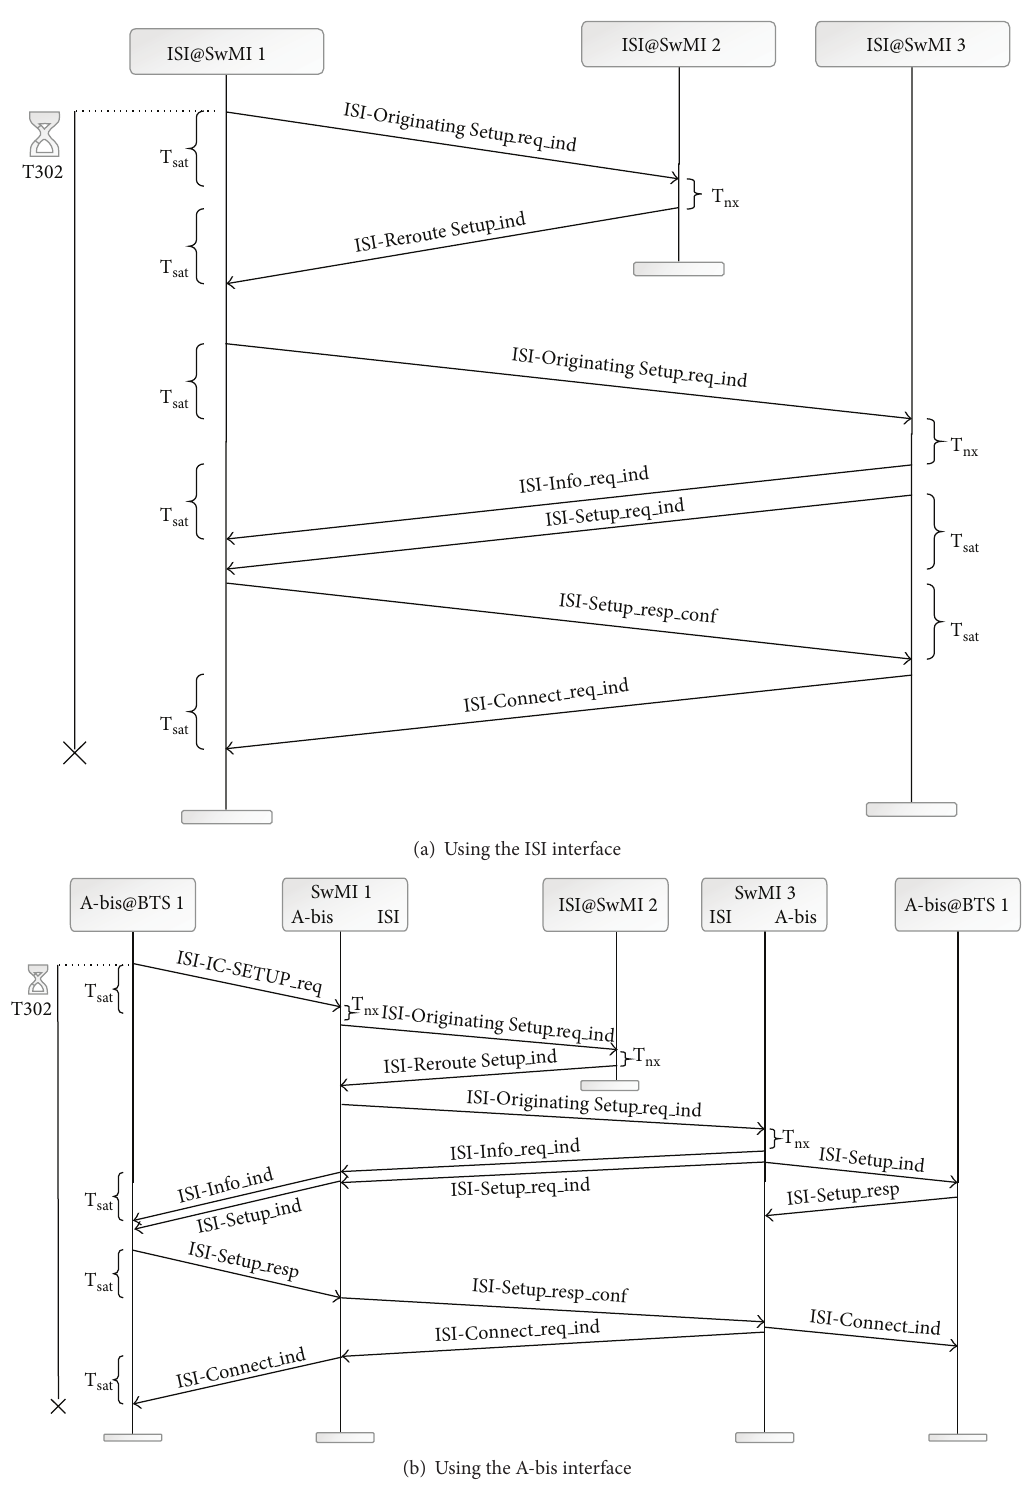
Figure 6: Successful group call setup for ISI and A-bis backhauling in scenario